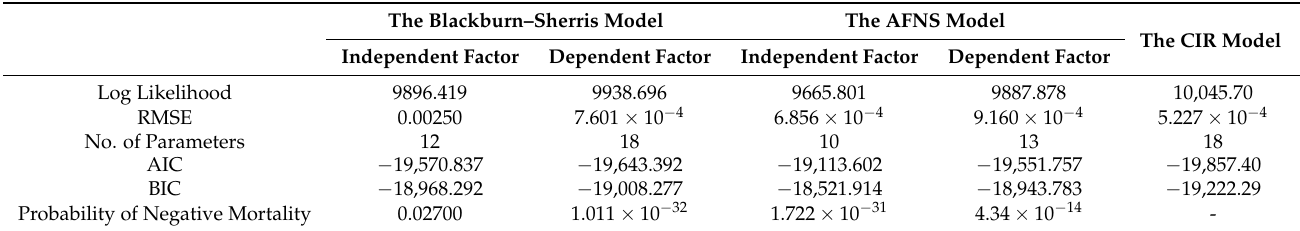
Table 3. Comparison of Affine Mortality